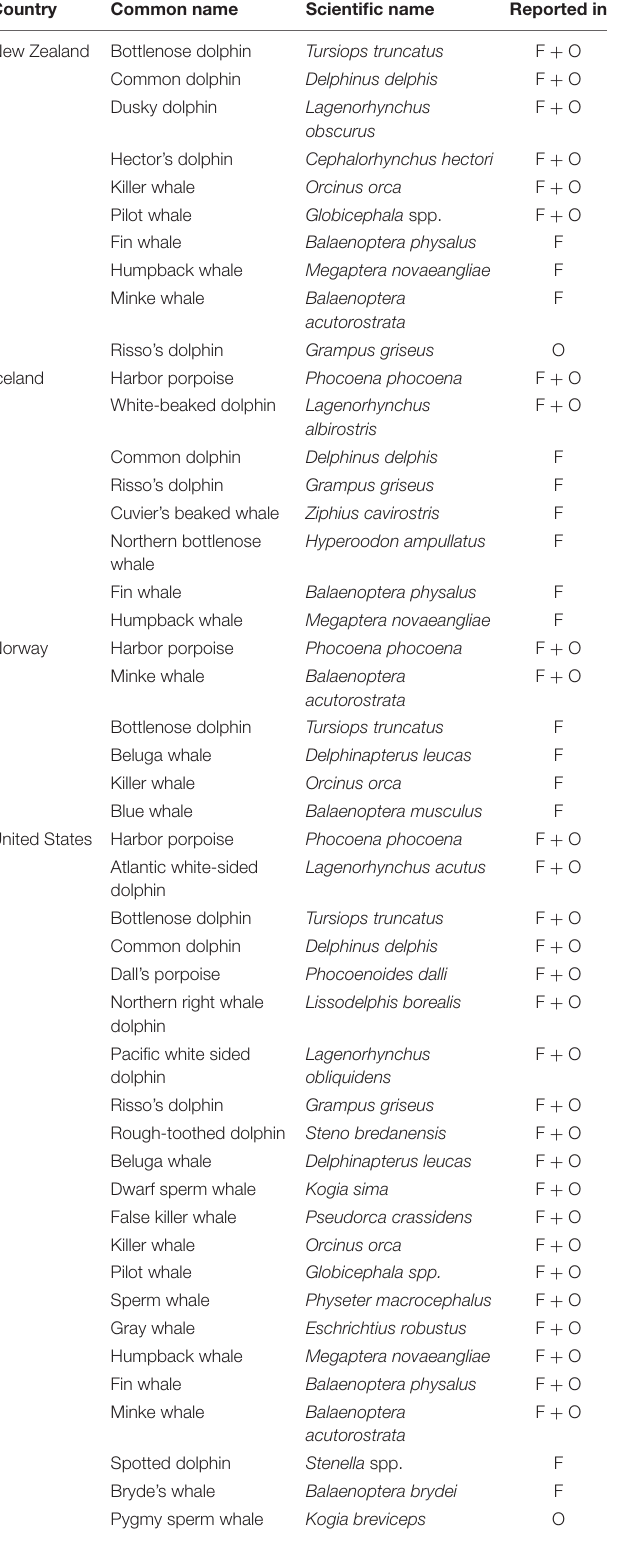
TABLE 2 | Cetacean species included in cetacean bycatch/interaction reports from each country, with indication of if they were reported in both fisher logbook and observer data (F + O), fisher logbook data only (F), or observer data only (O). Country